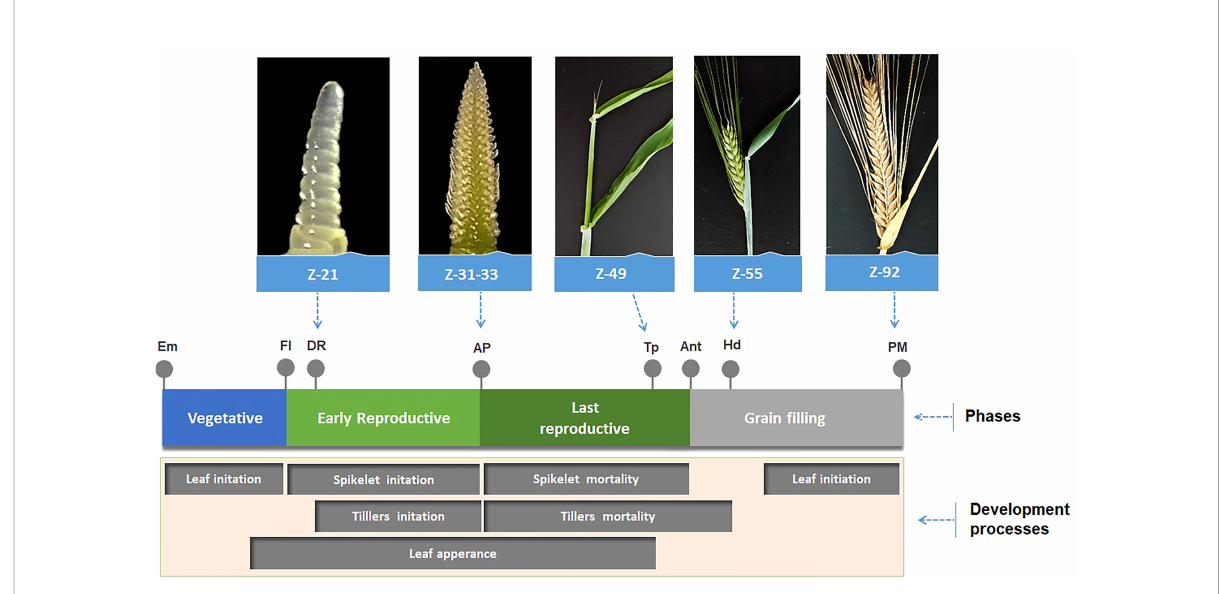
FIGURE 5 Schematic diagram of barley development showing the different stages (Em, Emergence; FI, Floral Initiation; DR, Double Ridge; AP, Awn Primordium (or MNP, Maximum number of spikelet primordia); Tp, Tipping; Ant, Anthesis; Hd, Heading; PM, Physiological Maturity; Z(n), Zadoks scale; phases and development